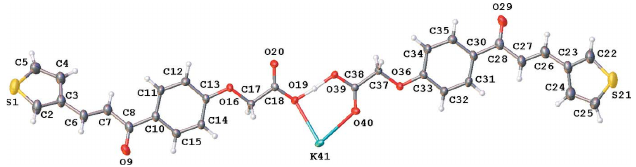
Figure 1 The molecular structure of the title compound, showing the atom- labelling scheme and displacement ellipsoids at the 30% probability